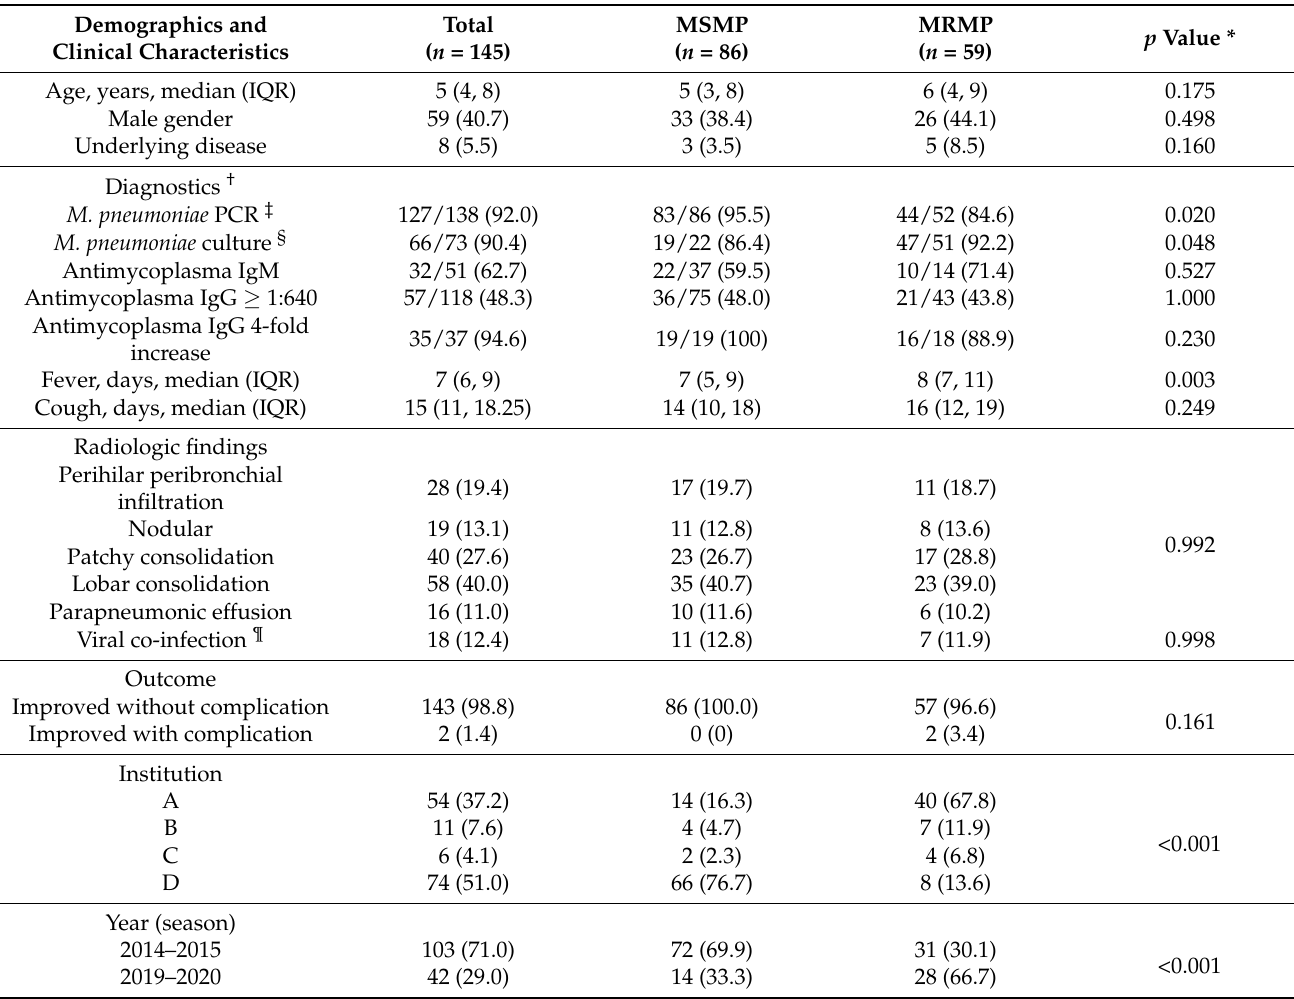
Table 1. Demographics and clinical characteristics of children with Mycoplasma pneumoniae pneumonia according to macrolide